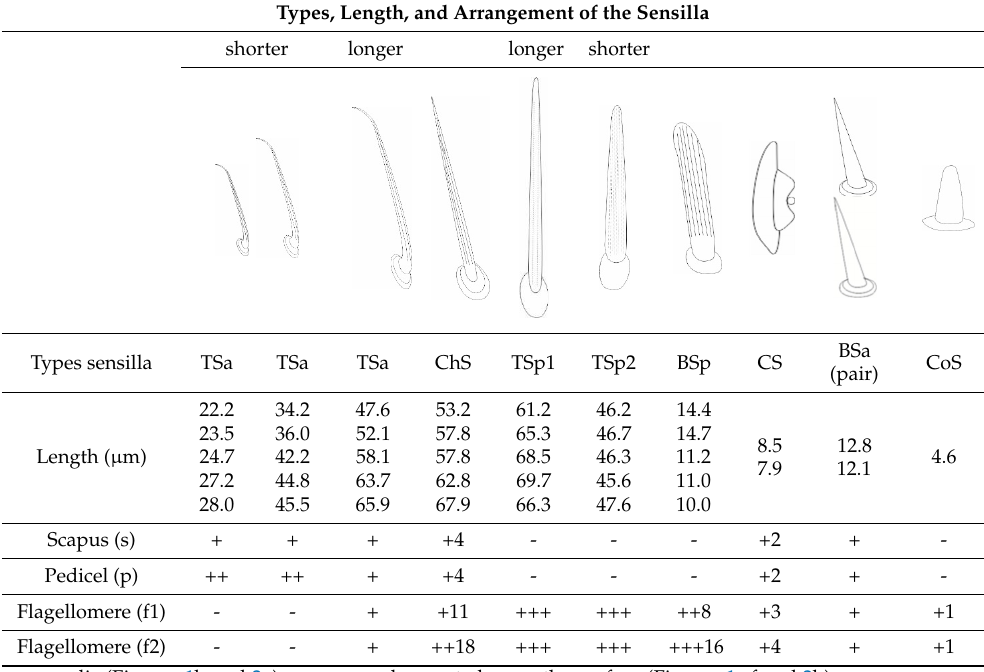
Table 1. The approximate lengths of the types of sensilla and their arrangement on the antennae are evaluated. Types, Length, and Arrangement of the Sensilla shorter longer